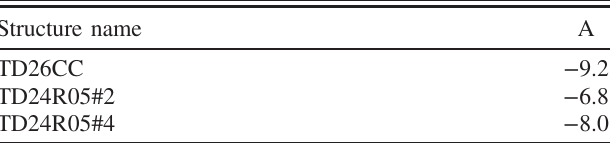
TABLE II. Summary of power law fit for the scaled breakdown rate of the structures under